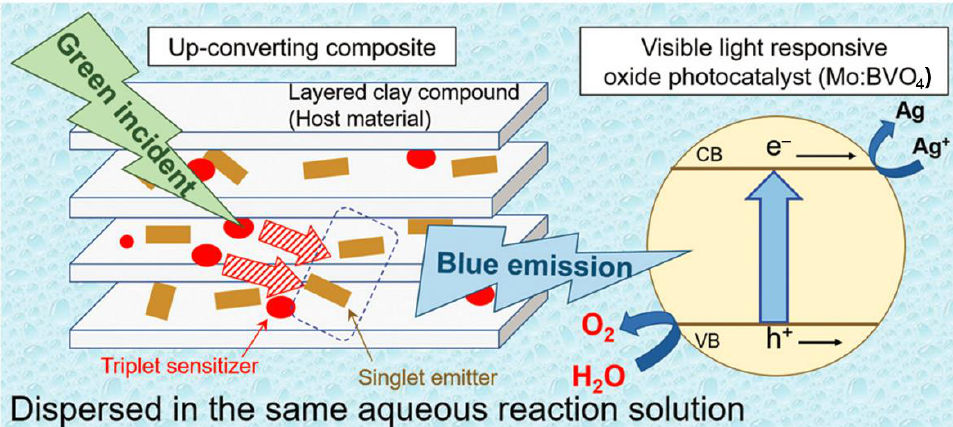
Figure 11. Schematic diagram of the photocatalytic OER triggered by TTA-UC from the composite photocatalyst containing PtOEP and DPA intercalated into a layered clay compound. Reprinted with permission from ref. [129]. Copyright The Royal Society of Chemistry 2021.